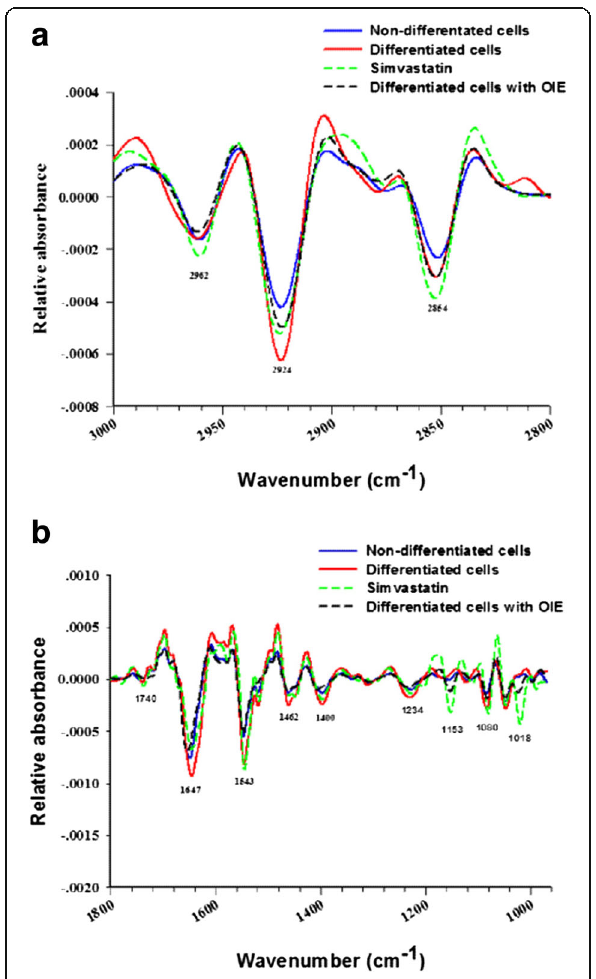
Fig. 6 Average the secondary derivative spectra of 3T3-L1 cells. The second derivative spectra of non-differentiated cells (pre-adipocytes), differentiated cells, simvastatin and Oroxylum indicum extract – treated differentiated cells after 10 days. The data were represented in two regions: a lipid regions (3000 – 2800 cm − 1 ) and b protein, nucleic acid, glycogen and other carbohydrate regions (1800 – 950 cm − 1 )